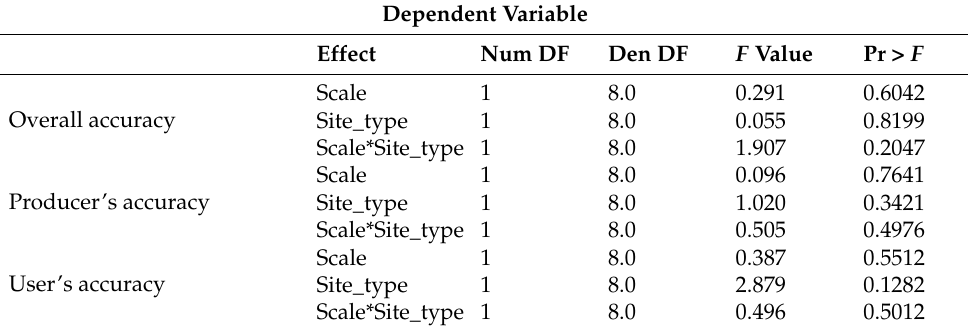
Table 7. Results for the mixed linear analysis for each tested accuracy (overall, EWM producer’s, and EWM user’s) using all sites and years. The random effect of site was not significant for all tests with a Wald p > 0.05. Dependent Variable Effect Num DF Den DF F Value Pr >